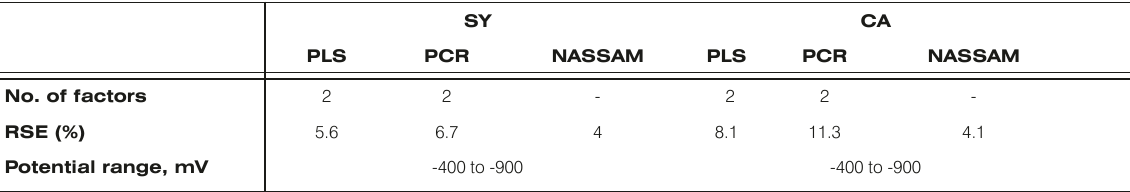
Table 3. Statistical parameters for the two analytes in synthetic mixtures.